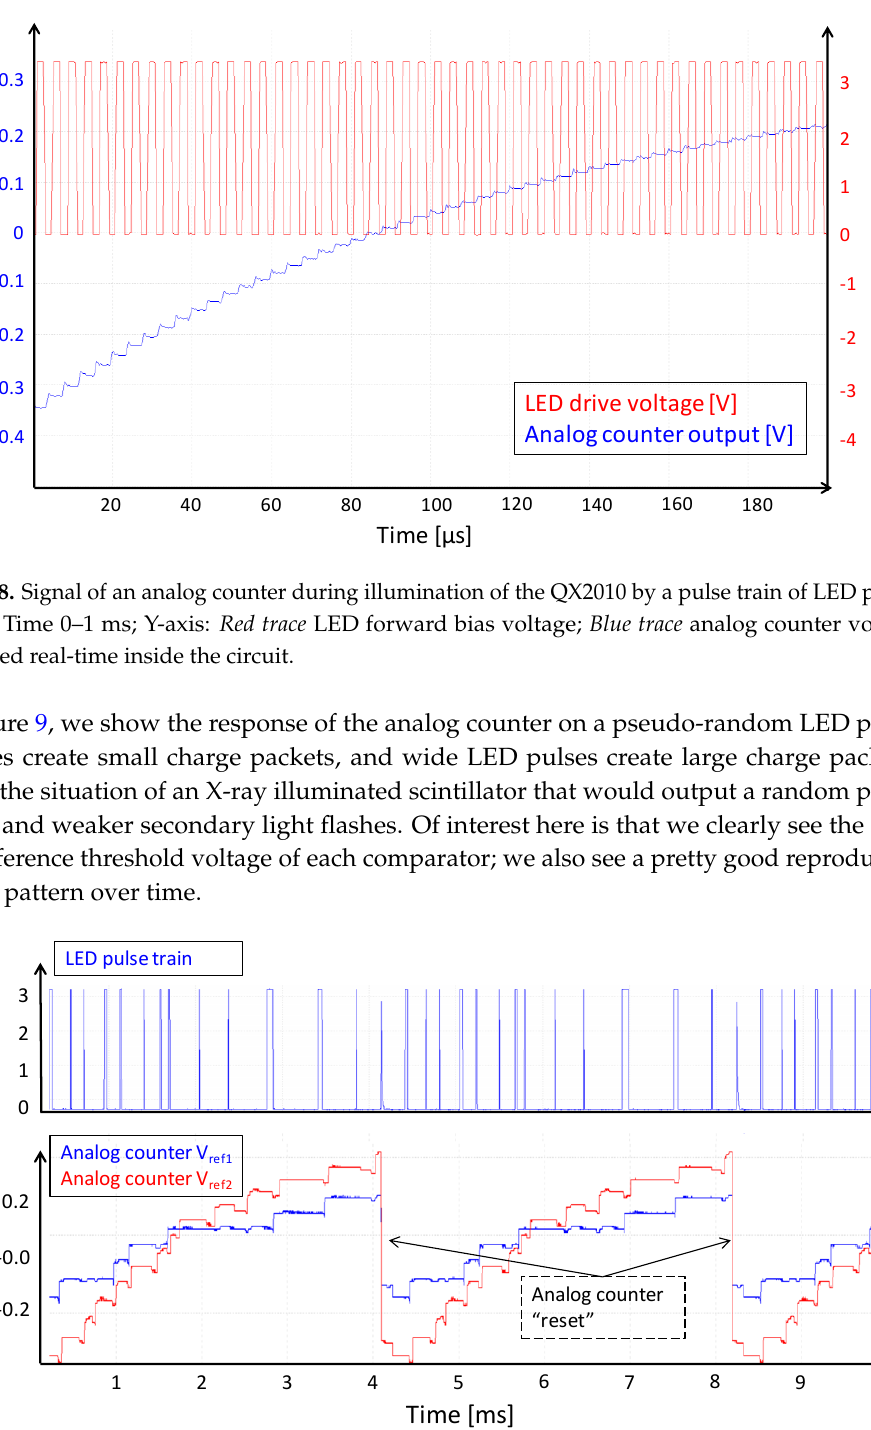
Figure 9. Demonstration of analog counting, emulating the variation of charge packet size by means of LED pulse width modulation. For the evaluation of noise and reproducibility, we defined a repeated random pattern of long and short LED pulses (blue top trace). The bottom traces are the two real-time observed analog counter outputs (with different Vref thresholds) of one pixel.